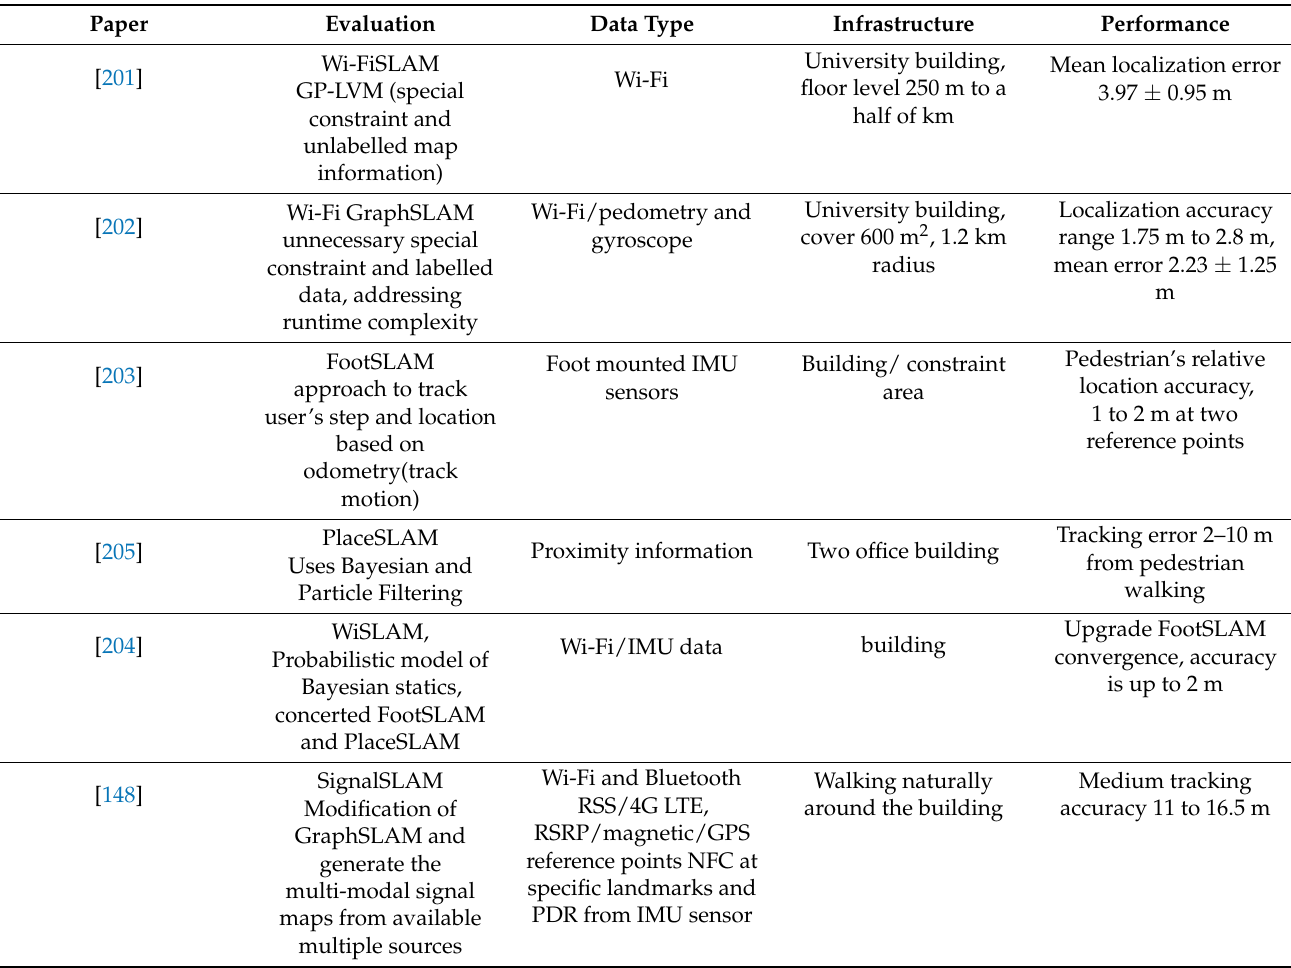
Table 5. The comparison of the location accuracy based on simultaneous localization and mapping (SLAM).